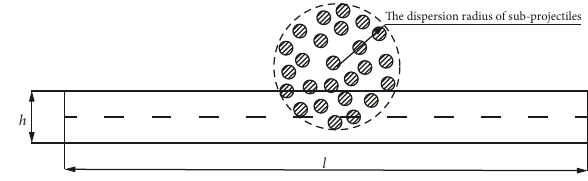
Figure 9: Schematic of the impact point of subprojectiles.